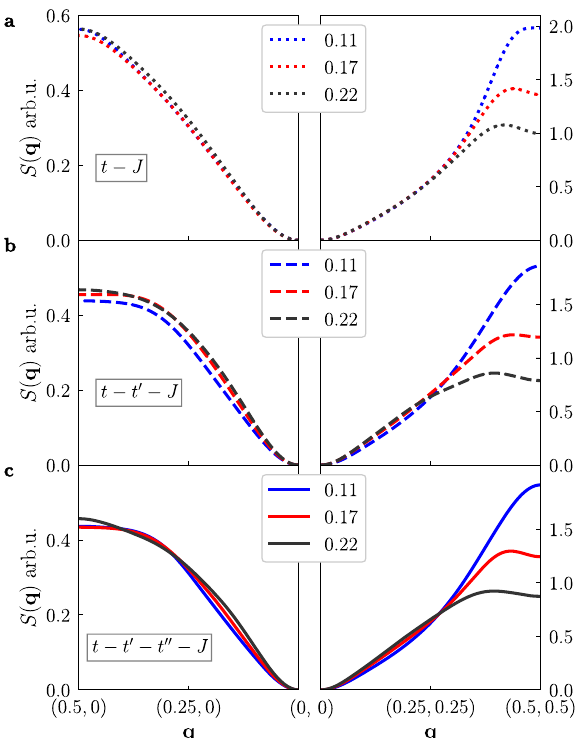
Fig. 6 Theoretical static spin structure factor and the longer- range electronic hoppings. Static spin structure factor S ( q ) obtained using DMRG on a 6 × 6 cluster (see text for further details) for three different hole-doping levels and a the t - J model, b the t - t 0 - J , and c the t - t 0 - t 00 - J model. Model parameters as in Fig. 5. Note the enlarged momentum coverage w.r.t. Fig. 5 and different scales of S ( q ) for the ( π , π ) and ( π , 0) directions of the Brillouin